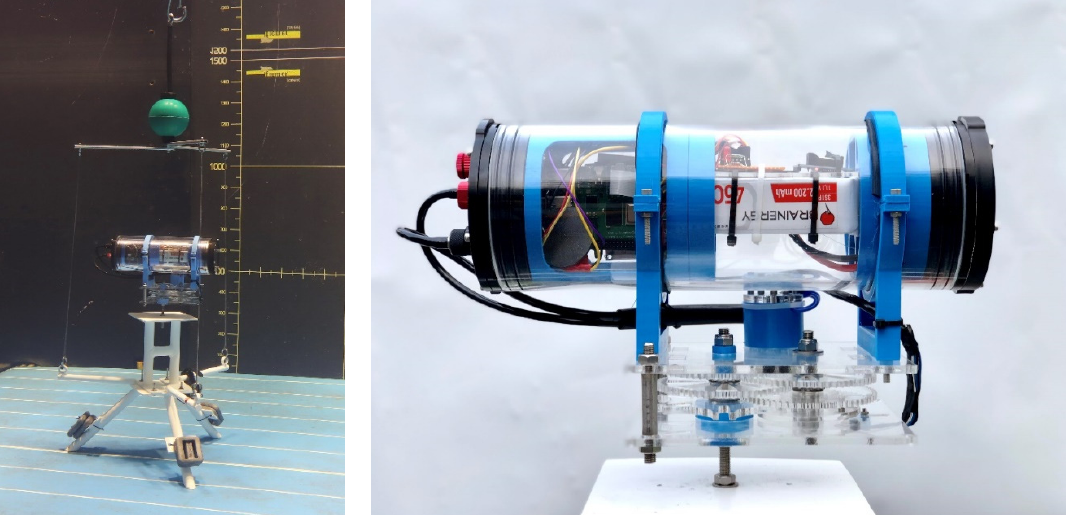
Figure 4. The KOSMOS prototype on its support and with the rigging ( left ). Side view of the housing and reducer ( right ). Table 1. List of components used for the KOSMOS prototype. The parts for the support and rigging are not detailed here. Part